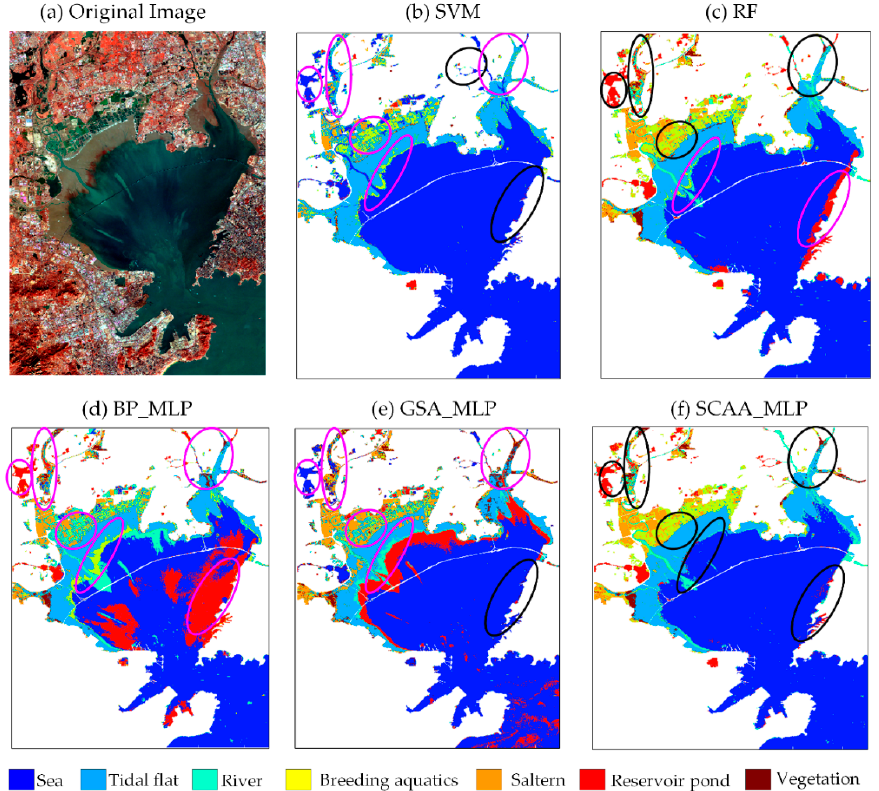
Figure 7. Classification results in Jiaozhou Bay wetland, with (a) an image subset (NIR, G, and B bands only), (b) support vector machine (SVM) classification, (c) random forest (RF) classification, (d) MLP classification, (e) gravitational search algorithm (GSA)–MLP classification, and (f) SCAA_MLP classification.